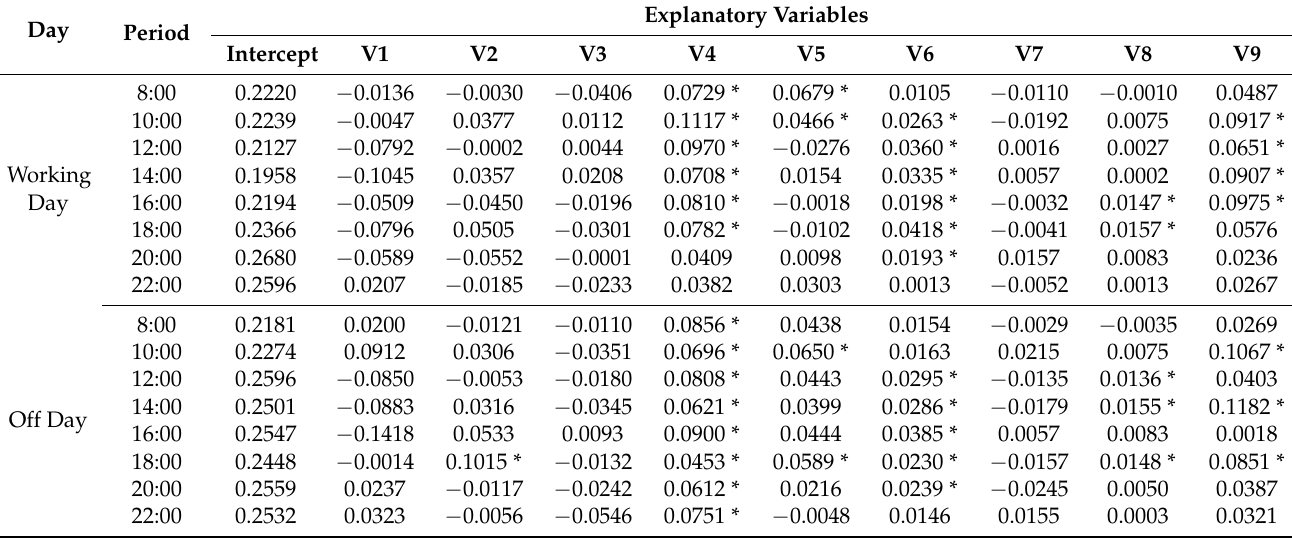
Table 8. The OLS regression results for the BDJ station